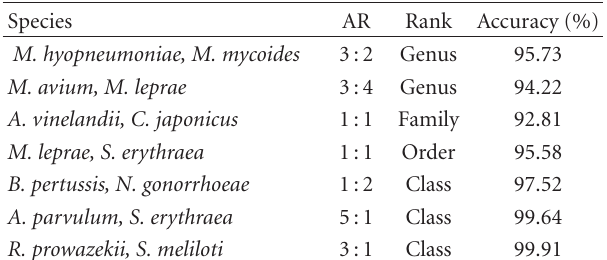
Table 4: Performance of Poisson mixture model (without word grouping) on datasets across various taxonomic ranks. Each dataset contains 50,000 reads of length 500 bp. AR stands for abundance